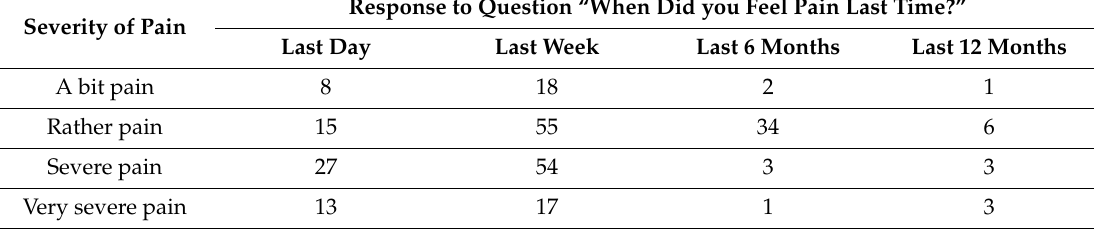
Table 4. Workers’ reporting on frequency with severity of pain.